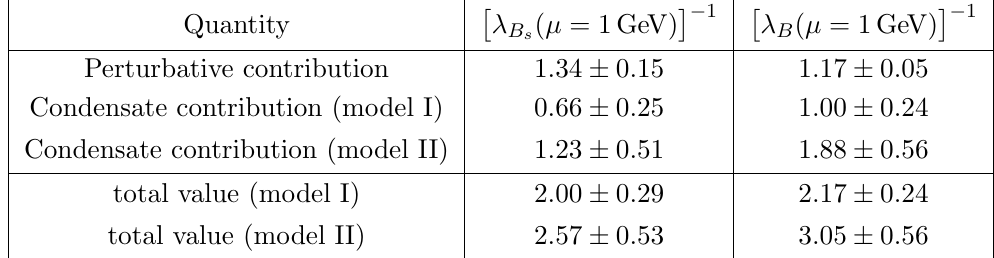
Table 2 . The QCD sum rule prediction for the inverse value of the B s and B DA inverse moment (in the units GeV (cid:0) 1